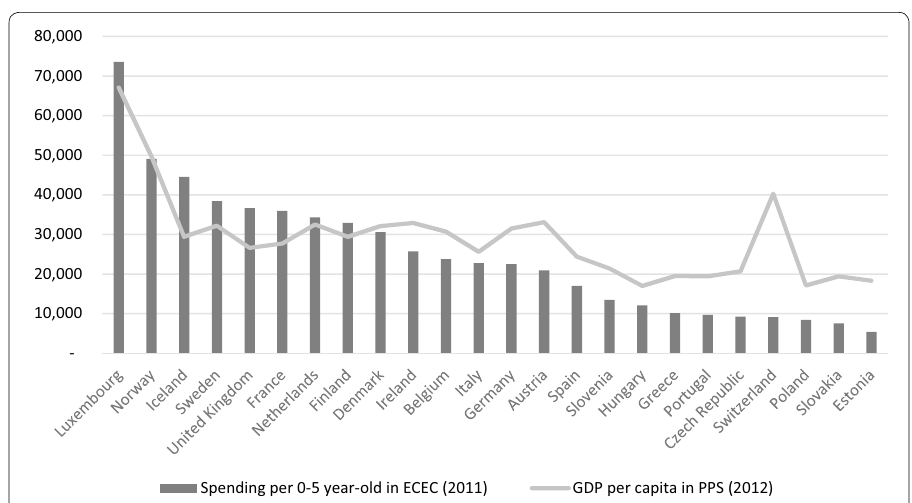
Fig. 4 Spending per 0–5-year-old in ECEC and GDP per capita (Sources: OECD Family Database and